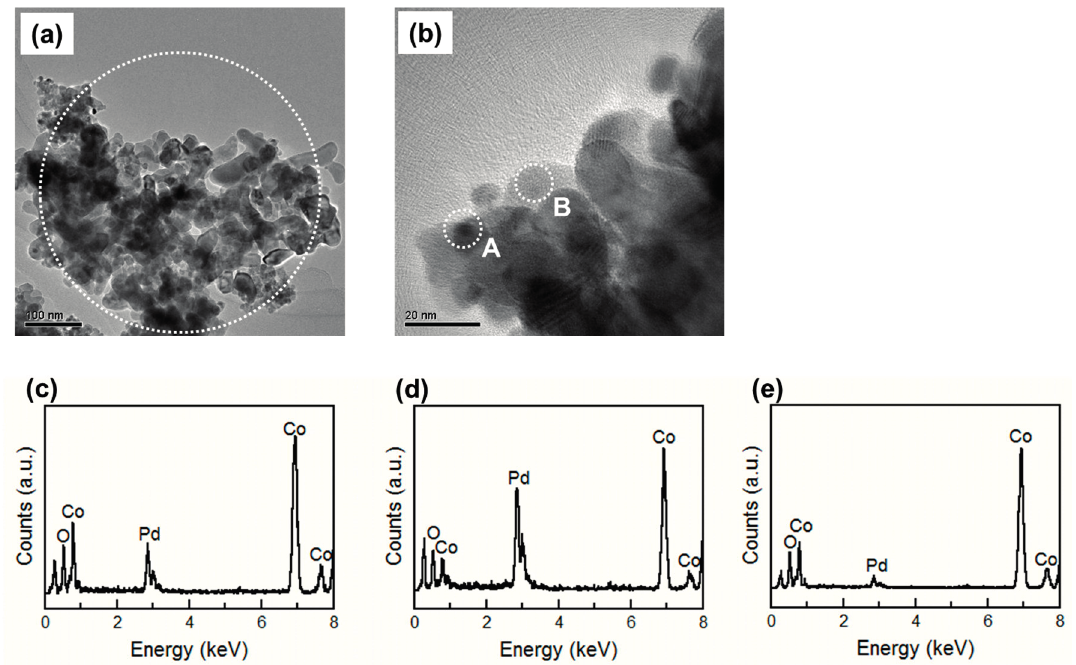
Figure 7. ( a , b ) TEM images of the 30%Pd/Co 3 O 4 powder; ( c ) EDX analysis result of the area inside the circle in the ( a ) image; ( d ) EDX analysis result of the area inside circle A; ( e ) EDX analysis result of the area inside circle B. The powder is baked at 400 °C for 2